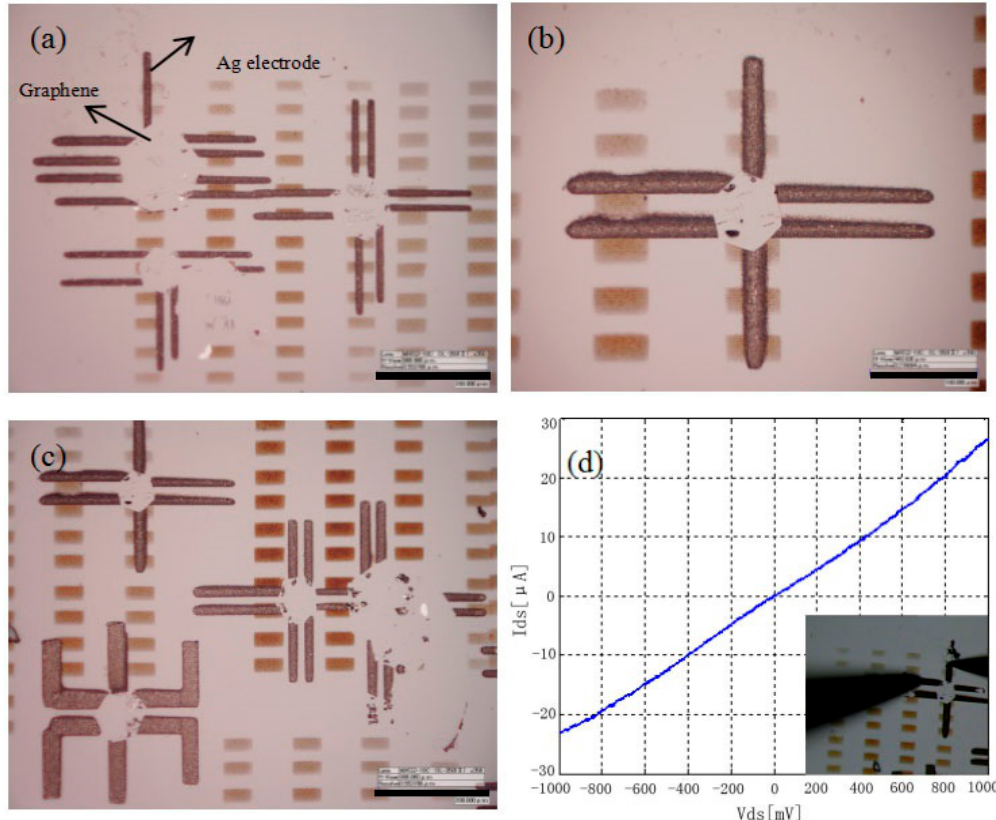
Figure 6. Large-scale graphene device assembly and current-voltage characteristics. ( a – c ) Optical images of different configurations of Ag electrodes connected at the edges of graphene. The hexagonal shapes correspond to single-crystal graphene. The black bars are 200, 100, and 200 µ m, respectively in ( a – c ); ( d ) current–voltage characteristics. The inset shows the optical image of two tungsten probes connecting the electrodes on an analytical probe station.